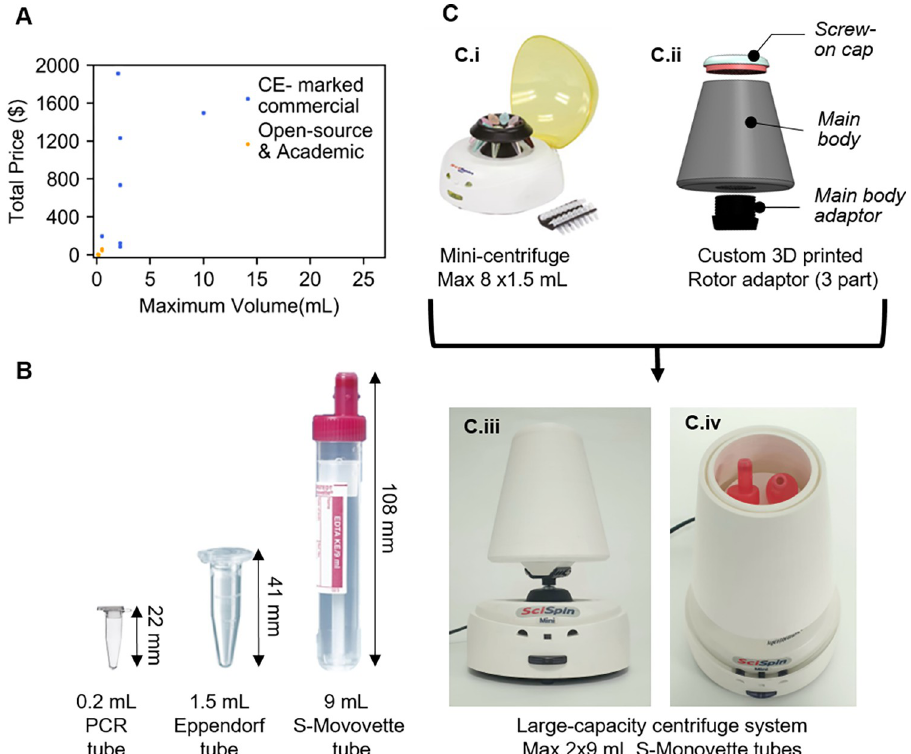
Fig 1. (A) Sample processing volume vs price of available commercial and open source academic microcentrifuges, ( B) Illustration of the different sized tubes used with the available microcentrifuges along with S-Monovette tube used in this project, ( C) Adaptor concept: C.i) Commercial SciSpin MINI Microfuge, model: SQ-6050 with its original rotors C.ii) CAD schematic of the designed three-part rotor adaptor C.iii) Final 3D printed rotor adaptor mounted